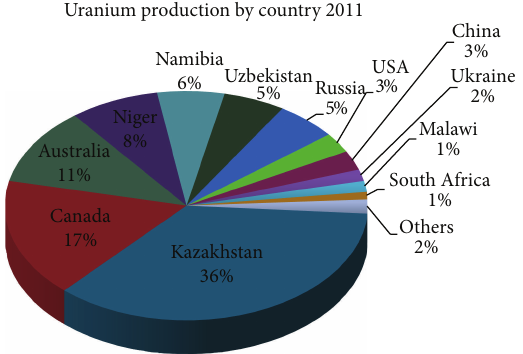
Figure 2: Uranium production by country in 2011. Source: Euratom Supply Agency, World Nuclear